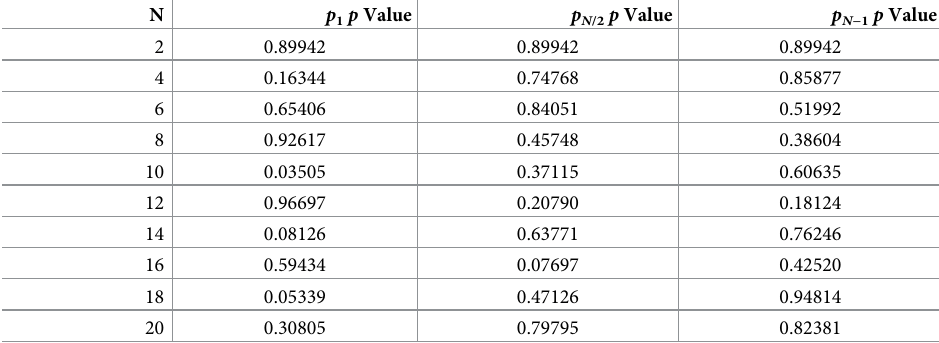
Table 2. p values resulting from a t test comparing the theoretic value with the simulated value of the Moran pro- cess fixation probabilities for deterministic strategies: Alternator and Cooperator. N p 1 p Value p N /2 p